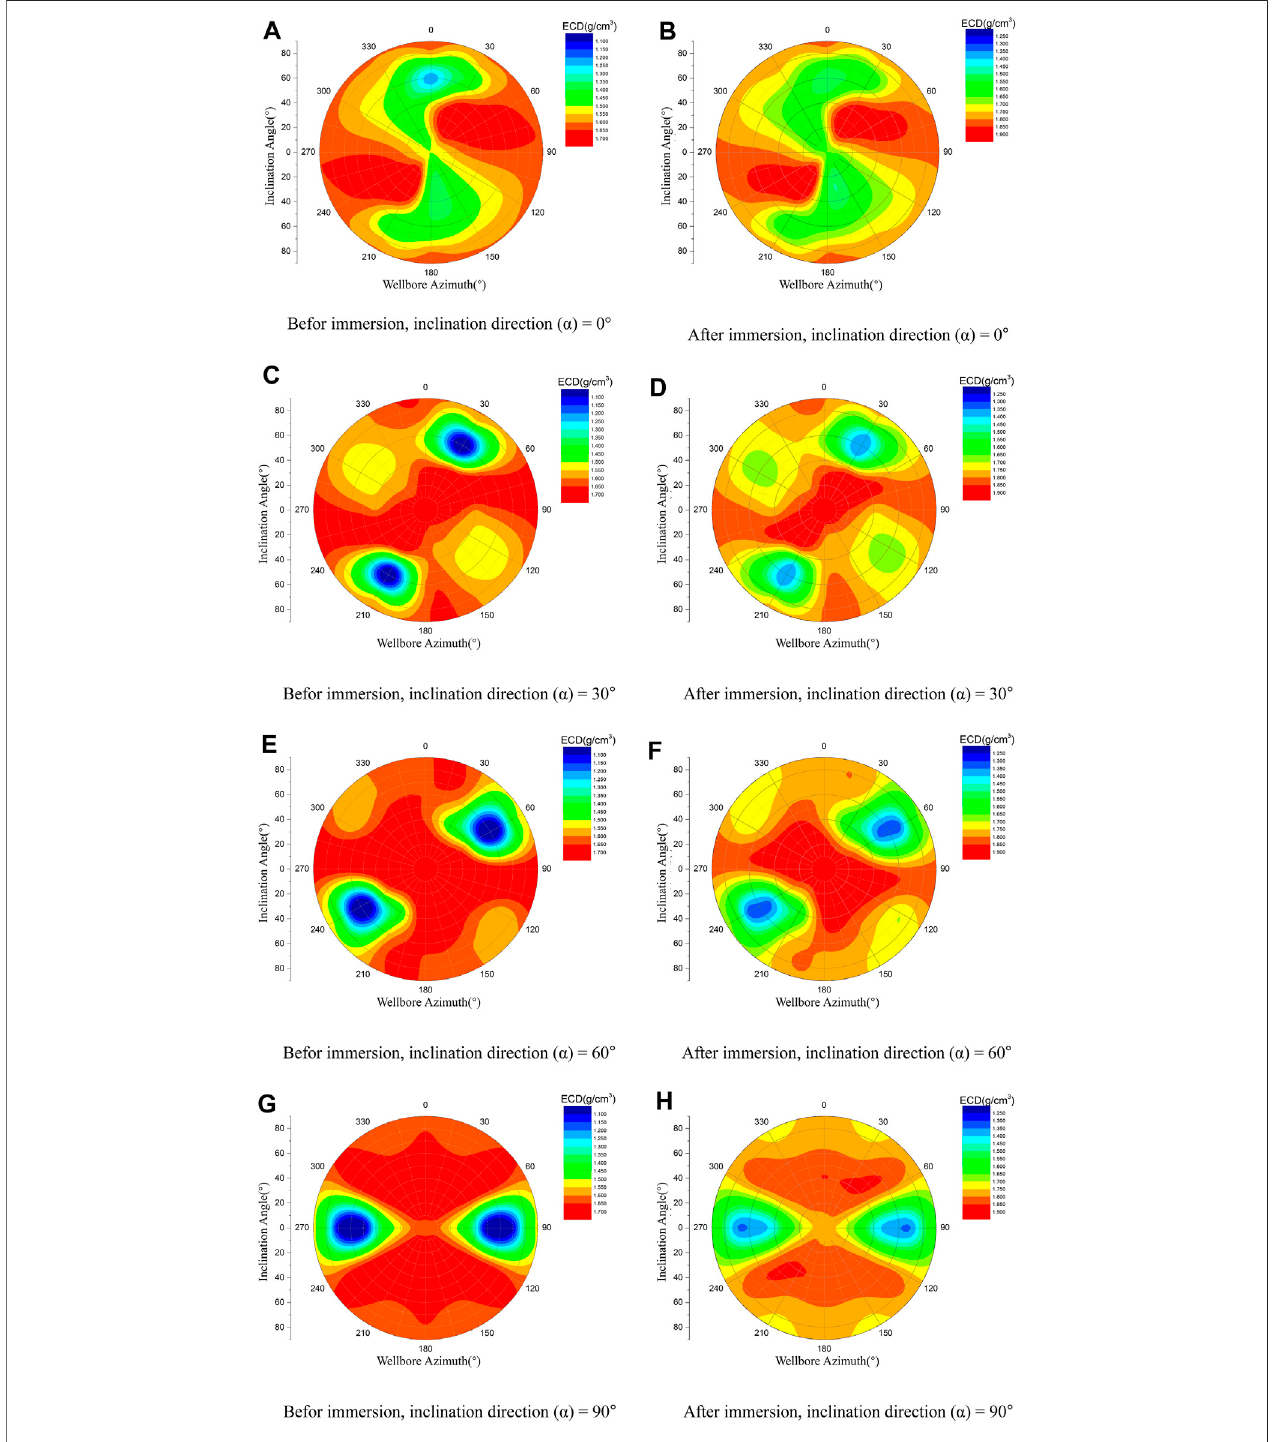
FIGURE 10 | The collapse pressure before and after soaking, when the bedding inclination angle( β ) is 60 ° .